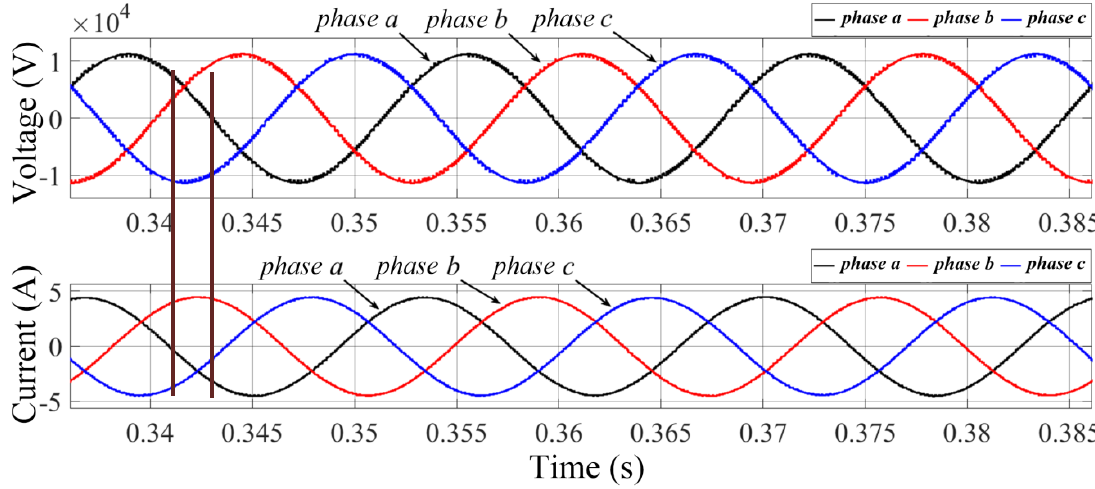
Figure 15. Voltage (upper, 10 kV / div) and current (lower, 5 A / div) imposed to TUT, F p = 0.7 capacitive. Horizontal axis: 5 ms / div.